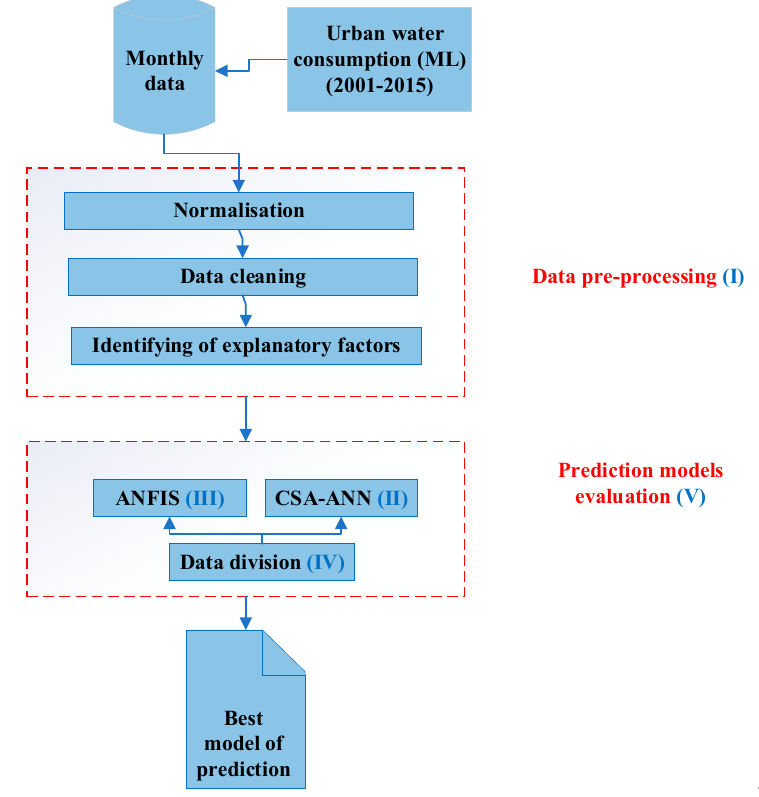
Figure 2. A scheme representing the methodology to predict monthly urban water demand based on historical observed data. ANFIS: adaptive neuro fuzzy inference system; CSA-ANN: hybrid crow search algorithm and artificial neural